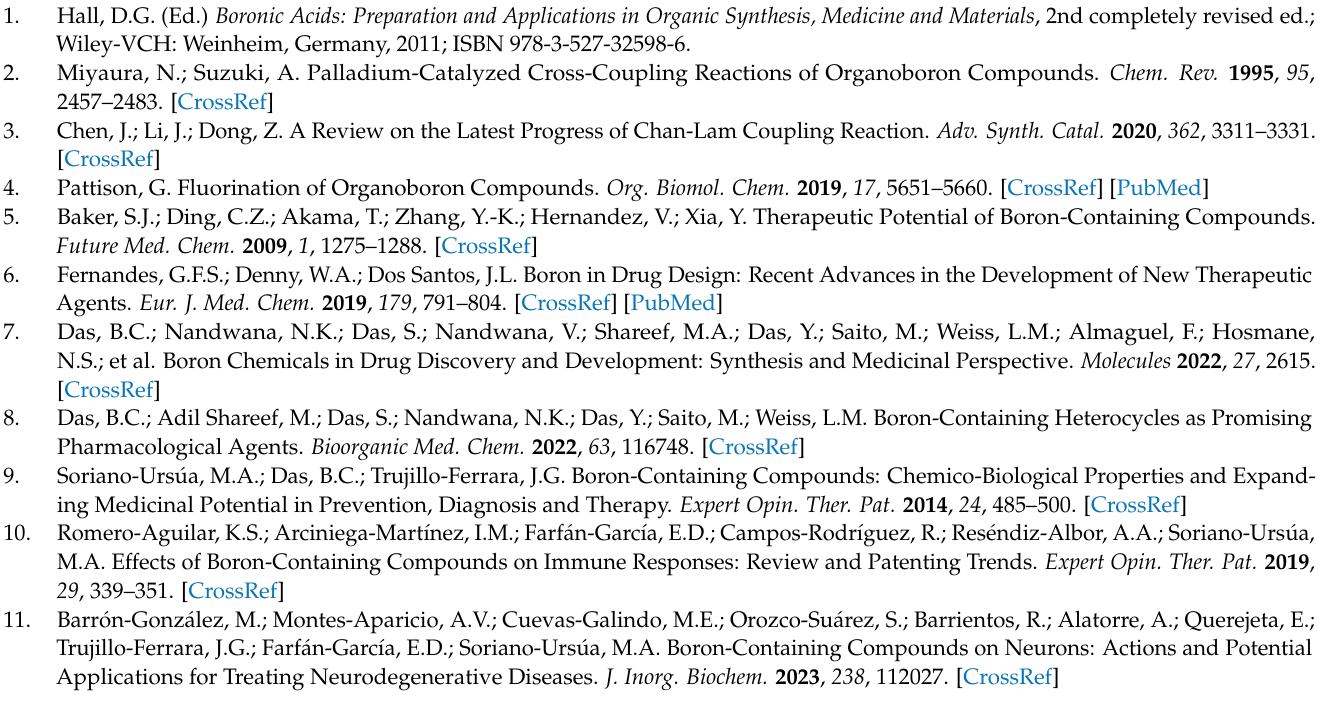
Table S1: Selected crystallographic and refinement